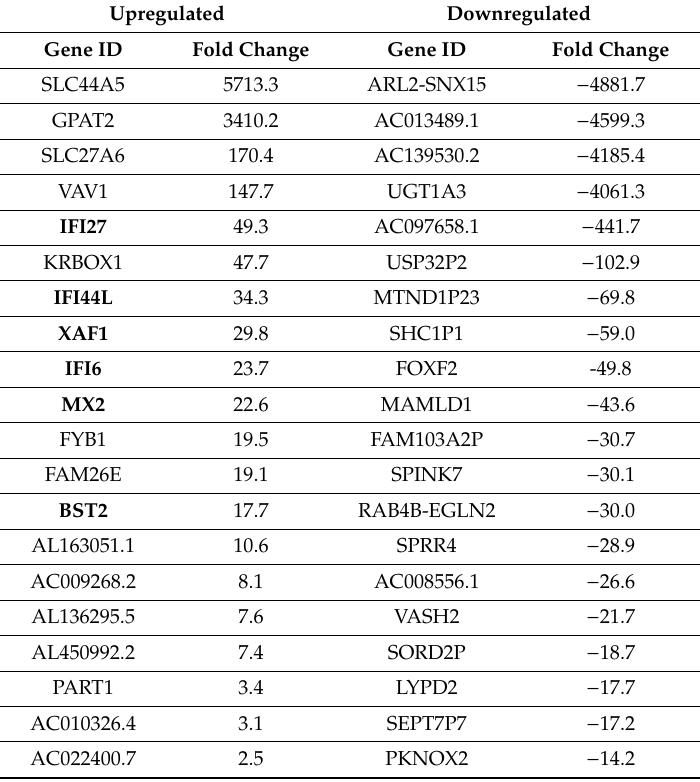
Table 3. RNA-sequencing results showing top 20 genes up- or downregulated in pLXSN E6 / E7 F57A cells, as compared to pLXSN E6 /